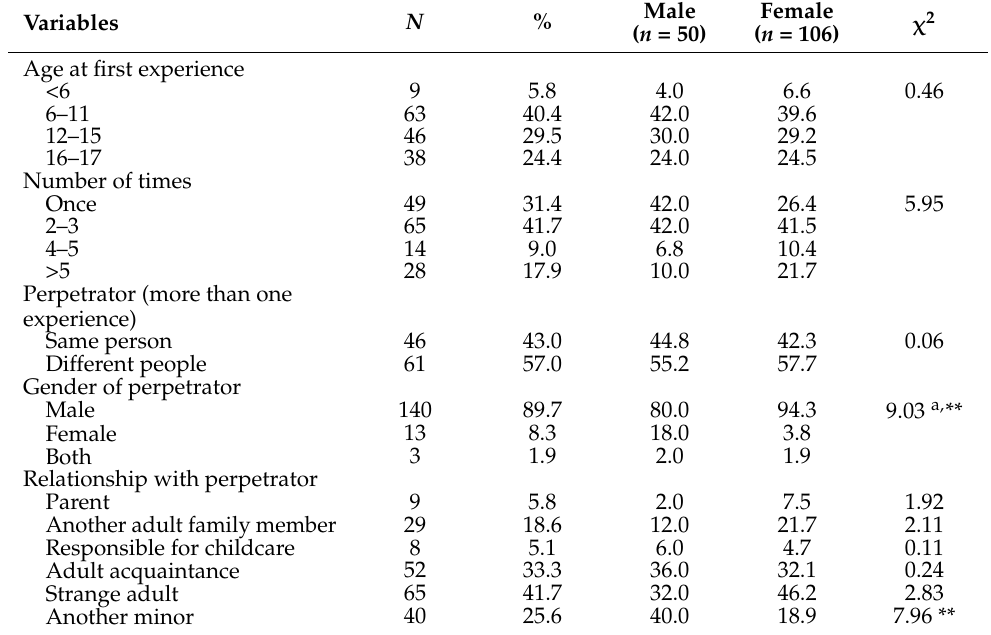
Table 1. Percentage of victim’s age at the first experience and perpetrator’s characteristics as a function of gender for “somebody rubbed his/her private parts against me”.